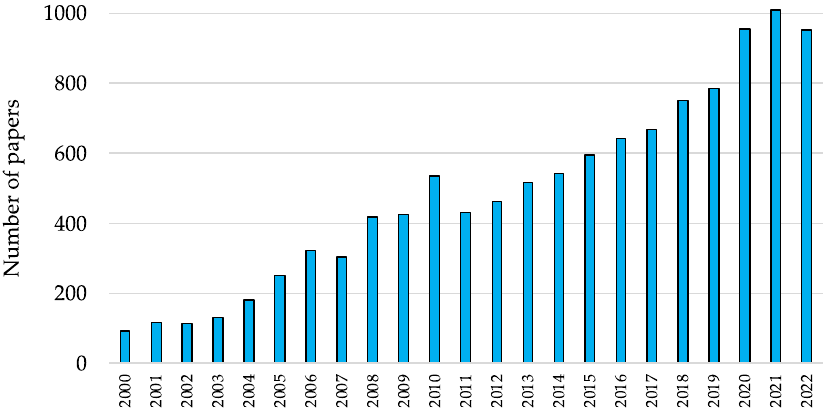
Figure 1. Number of papers published between 2000 and 2022, which were retrieved using a literature search on PubMed (www.ncbi.nlm.nih.gov/pubmed/) with the query term “rejuvenation”. More than 80 research papers and reviews were considered in the current article.